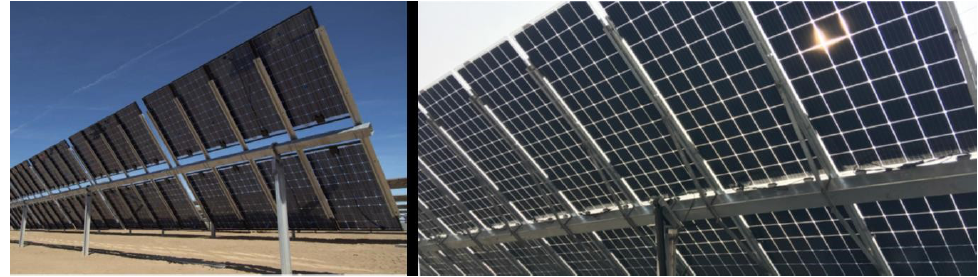
Figure 13. One-axis trackers designed for bifacial modules.